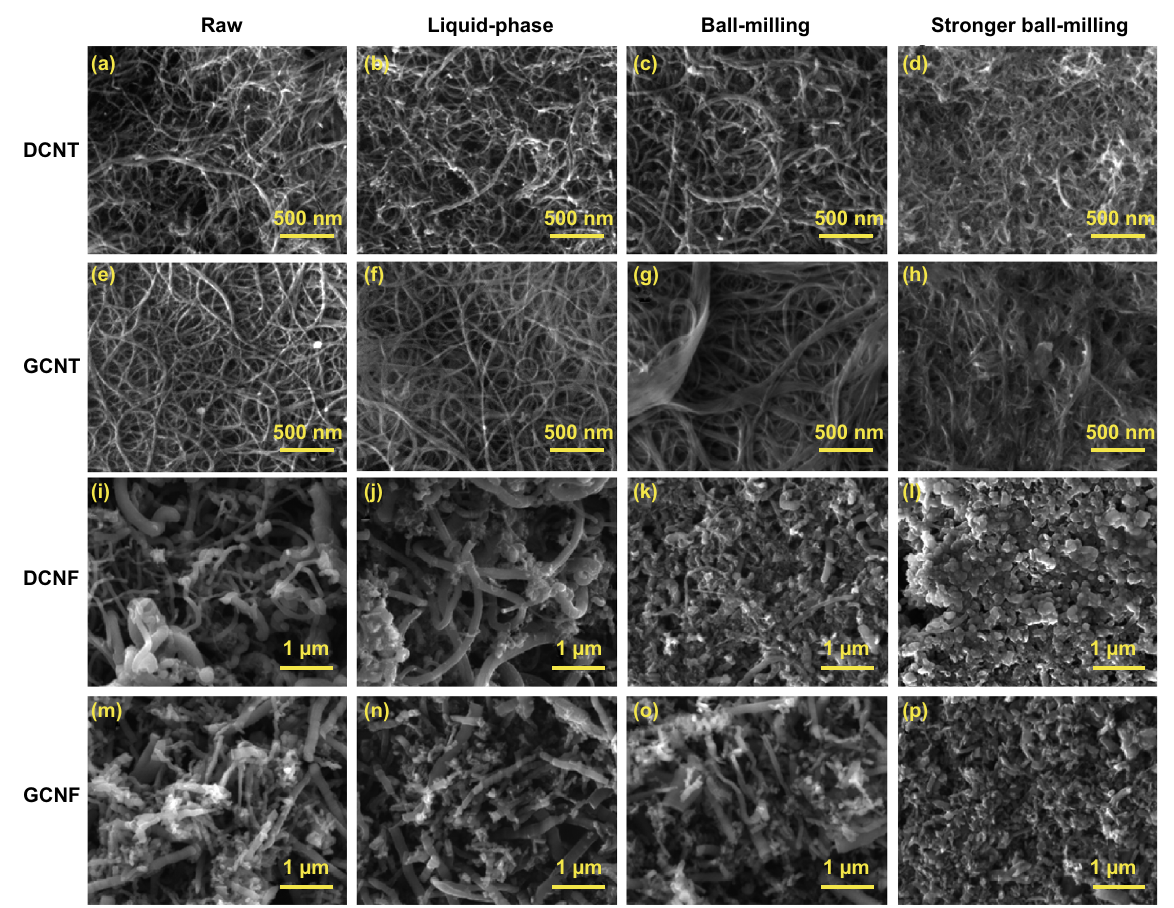
Fig. 4 SEM images of carbon nanomaterials under different reaction conditions. a–d DCNTs: a raw, b L2, c S2 at 250 rpm, d S2 at 300 rpm; e–h GCNTs: e raw, f L8, g S8 at 250 rpm, h S8 at 300 rpm; i-l DCNFs: i raw, j L2, k S2 at 100 rpm, l S2 at 250 rpm; m-p GCNFs: m raw, n L8,